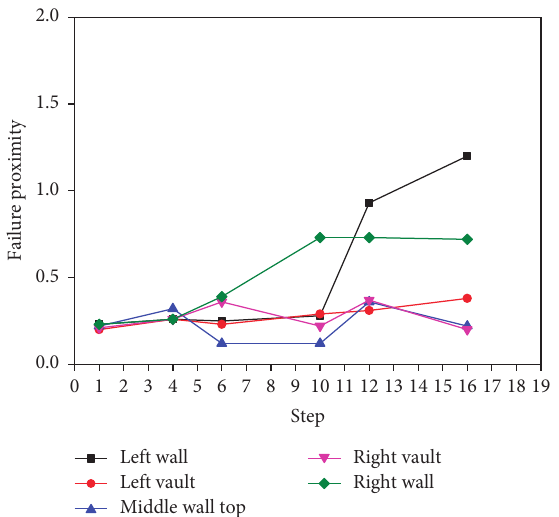
Left vault Middle wall top Right vault Right wallLeft wall